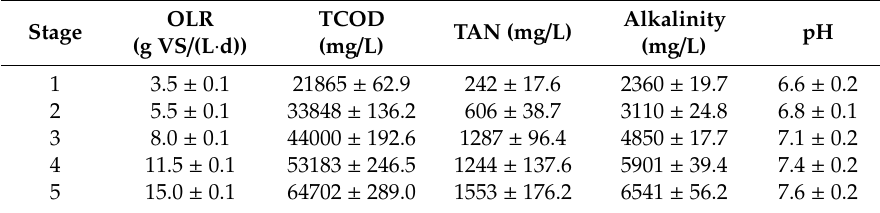
Table 2. Characteristics of the digestate inside the CSTR at each